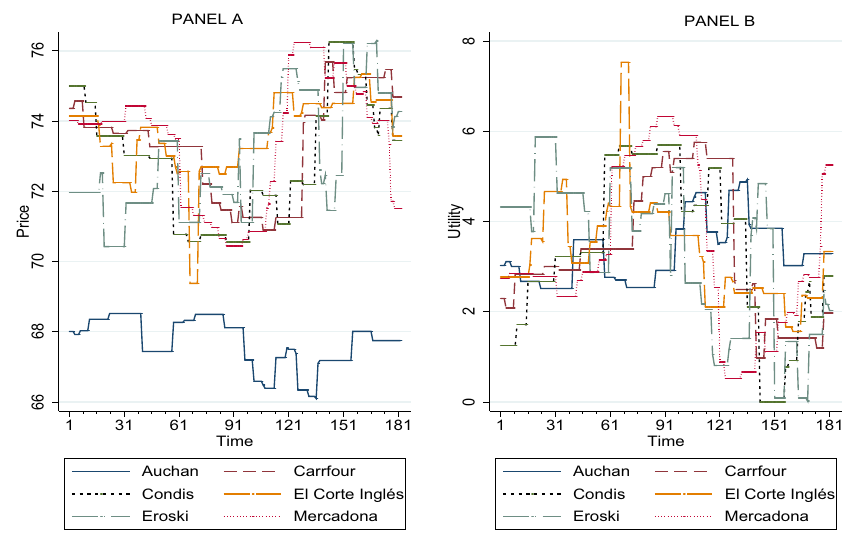
Fig. 3 Ranking over time: occasional basket (Barcelona)